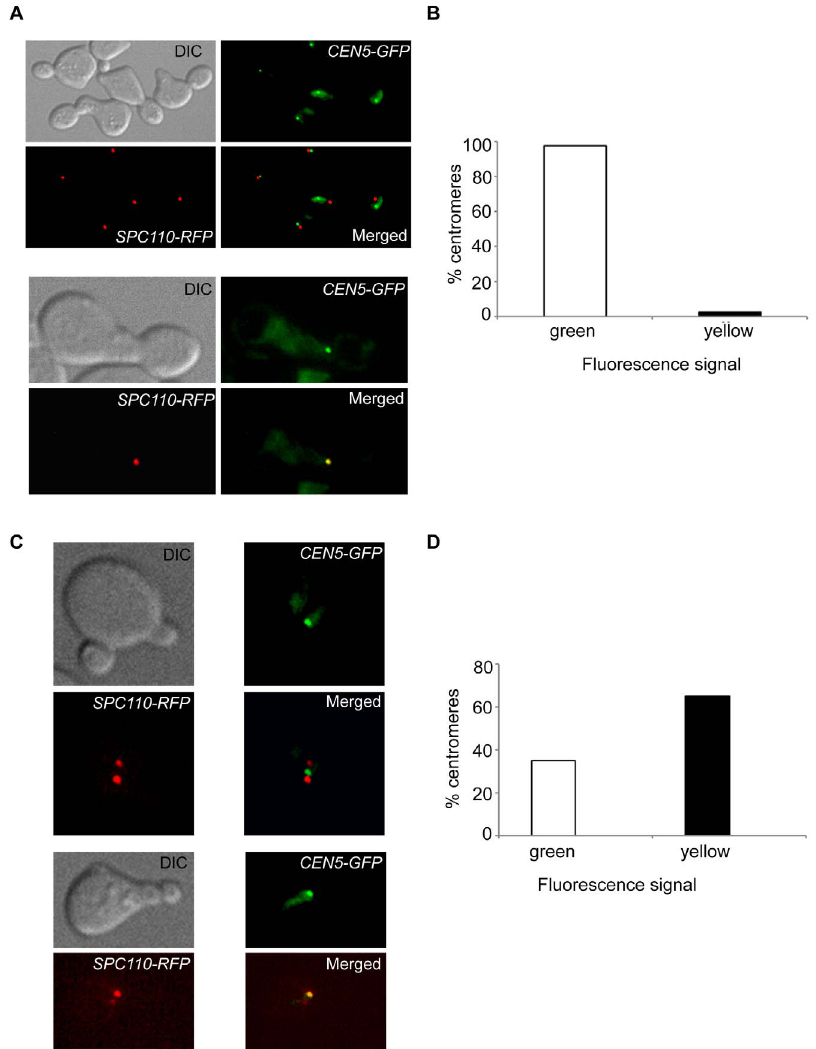
Figure 2. Protein-protein interactions between SPB and KT components do not contribute to SPB-centromere proximity. Exponentially growing cells of the wild-type strain PS1 ( CHL4 CTF19 ), carrying its CEN5 tagged with GFP and its Spc110p (an SPB protein) tagged with the RFP, were arrested in G1 by a -factor for 120 minutes. Thereafter, the cells were released from G1 arrest at 30 u C in YEPD carrying nocodazole (15 m g/ml) or no nocodazole (control cells). Cells subjected to nocodazole were fixed with formaldehyde and processed for fluorescence microscopy 2 hours after release from G1 arrest. Control cells were fixed and processed similarly after 40 minutes of release from G1 arrest. (A) Upper two panels show a field of nocodazole-treated cells, each having its CEN5 (green dot) non-colocalized with its SPB (red spot due to Spc110p-RFP). Lower two panels show the lone cell (one out of a total of forty analyzed) having its CEN5 colocalized with SPB. (B) The bar diagram depicts percentages of centromeres which overlapped (yellow dots) and did not overlap (green dots) with SPB in the presence of nocodazole. (C) Fluorescence microscopy images of control (untreated with nocodazole) cells having non-overlapping (upper two panels) and overlapping (lower two panels) signals of CEN5 - GFP and Spc110p-RFP (SPB). Note that the two SPBs (each tagged with Spc110-RFP) get separated from each other by MTs (not stained in this experiment) due to the absence of nocodazole. (D) The bar diagram represents percentages of centromeres showing overlapping (yellow) and non- overlapping (green and red) CEN5 and SPB signals in S-phase in the presence of MTs. A total of 68 cells with two SPBs (indicated by two Spc110-RFP spots) were analyzed. obtained following Cui et al., after deconvolving the images using MetaMorph 2D deconvolution software (nearest neighbors algo- rithm) [34]. First the sections with highest GFP and RFP intensity were identified. The vertical distance ‘a’ between the centromere and spindle pole was obtained from z-sections of nucleus, whereas ‘b’ being their horizontal displacement was determined by 2D projecting of the highest intensity stacks and measuring the 2D distance from center of GFP spot to the center of RFP spot. The ffiffiffiffiffiffiffiffiffiffiffiffiffiffi a 2 z b 2 p . 3D distance ( d ) was derived using the equation d ~